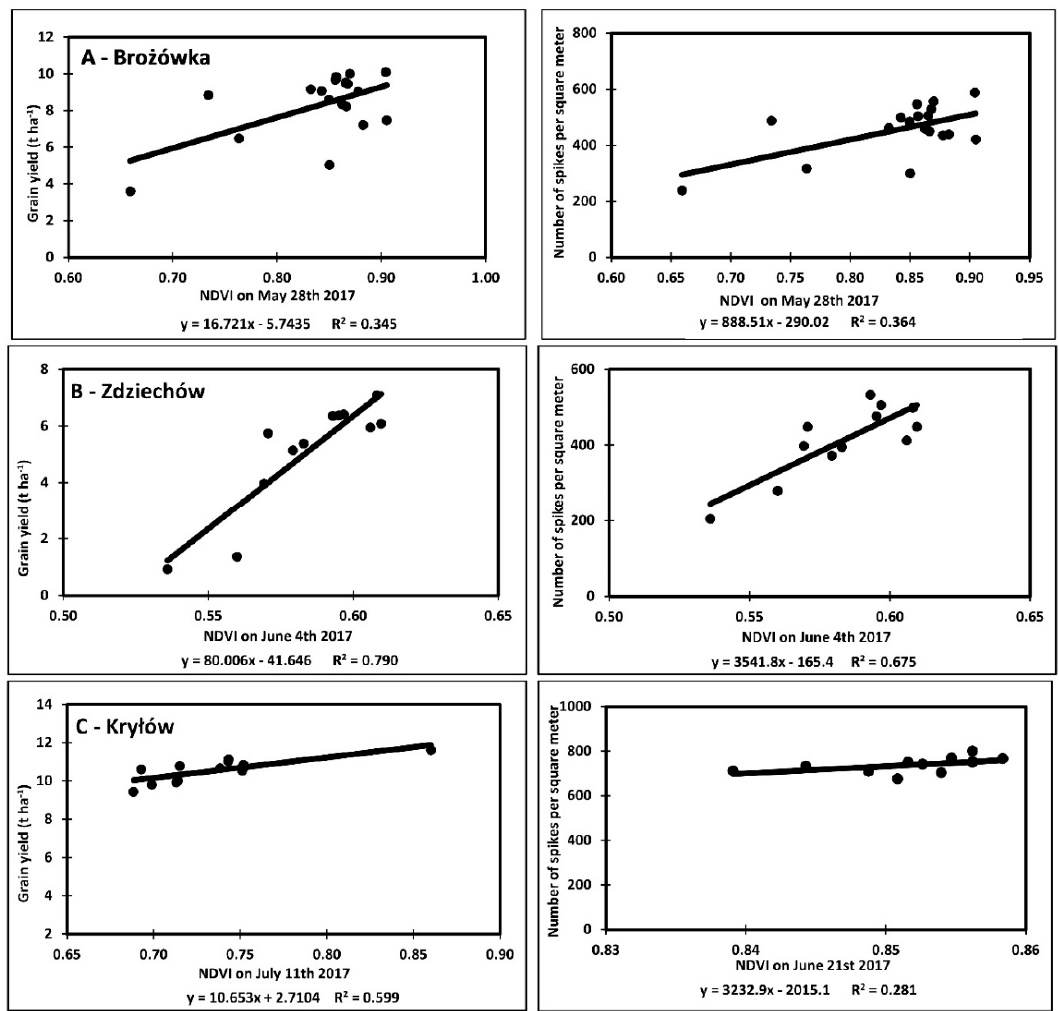
Figure 5. Relationships between grain yield (charts in the left side), number of spikes per square meter (charts in the right side) and NDVI values for three locations (A—Bro ż ówka, B—Zdziechów, C— Kry ł ów) for the dates when the correlations reached maximum values in 2017. Regression equations and the value of the R 2 coefficient are given for each relationship.